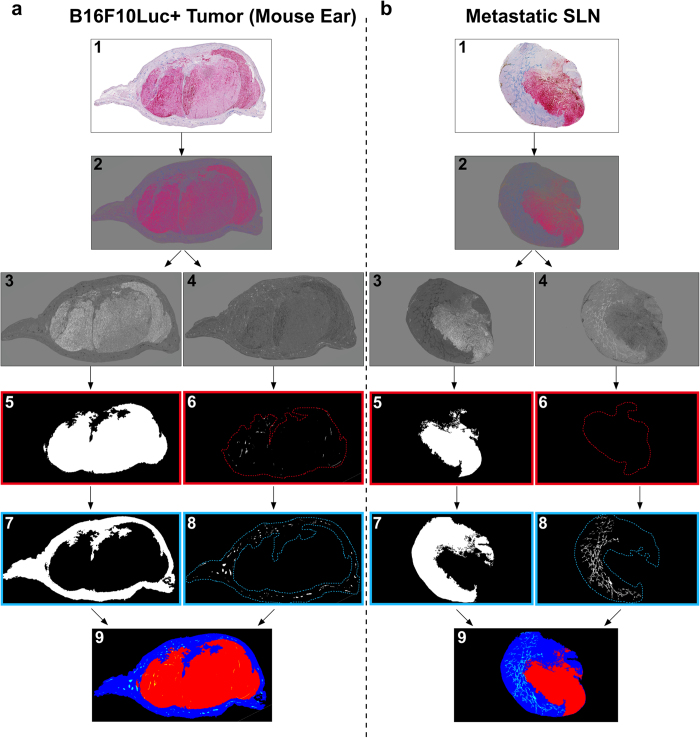
Computerized-assisted 2D image processing.Sections of the primary tumors (mouse ears) (a) and metastatic LNs (b) were immunostained for lymphatic vessels (LYVE-1 positivity in blue) and tumor cells (tyrosinase positivity in pink) (image 1), and subjected to image processing (images 2–9). (2) Contrast color enhancement using excess transformation. (3–4) Color image decomposition into its grey level components corresponding to (3) tumor (red component) and (4) lymphatic vessels (blue component). (5, 7) Automatic binarization of the (5) tumor and the (7) peritumoral region. (6, 8) Automatic binarization of (6) intratumoral vessels (confined inside the red dotted lines), and (8) peritumoral vessels (confined inside the blue dotted lines). (9) Color image compiling all the previous detected structures (peritumoral area in blue, tumor area in red, peritumoral vessels in light blue and intratumoral vessels in yellow).